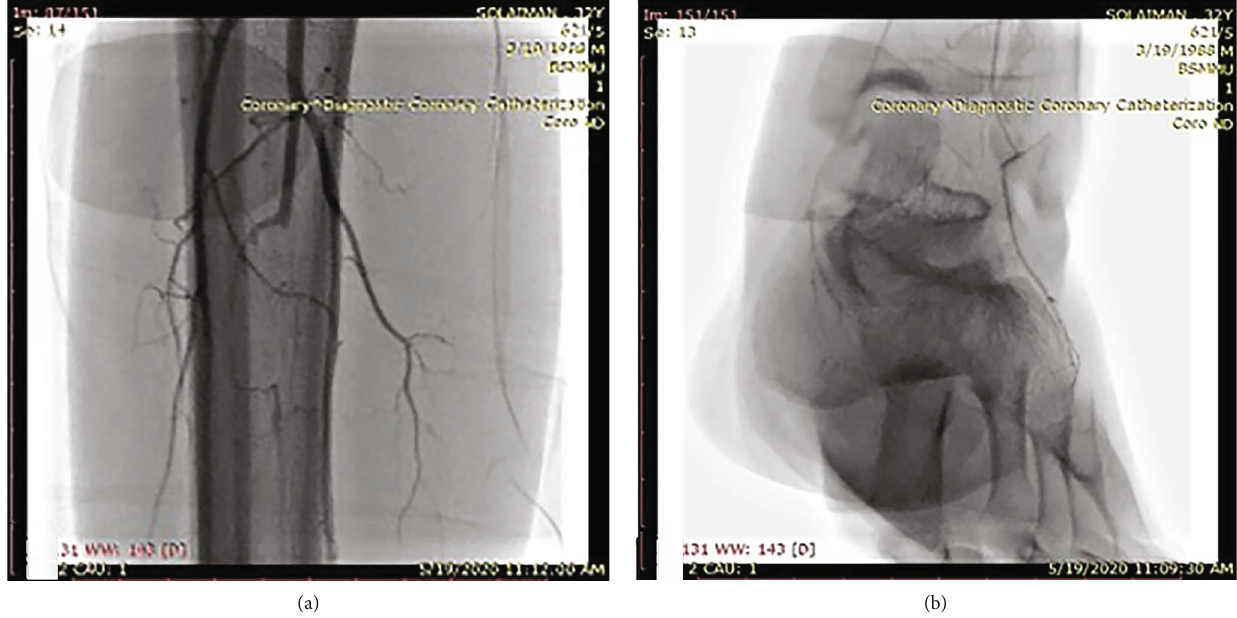
Figure 4: (a) Arteriography showing nonvisualized right anterior tibial artery from the middle part of the tibia. Note the absence of corkscrew collaterals or microaneurysm; (b) the arteria dorsalis pedis and the dorsal arch are